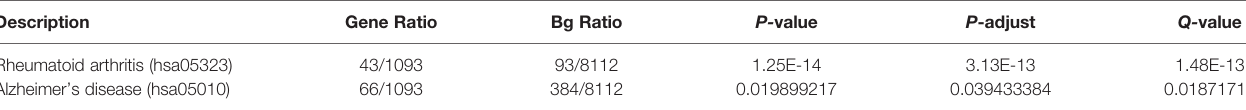
TABLE 1 | Results of KEGG enrichment analysis of RA and AD pathways.